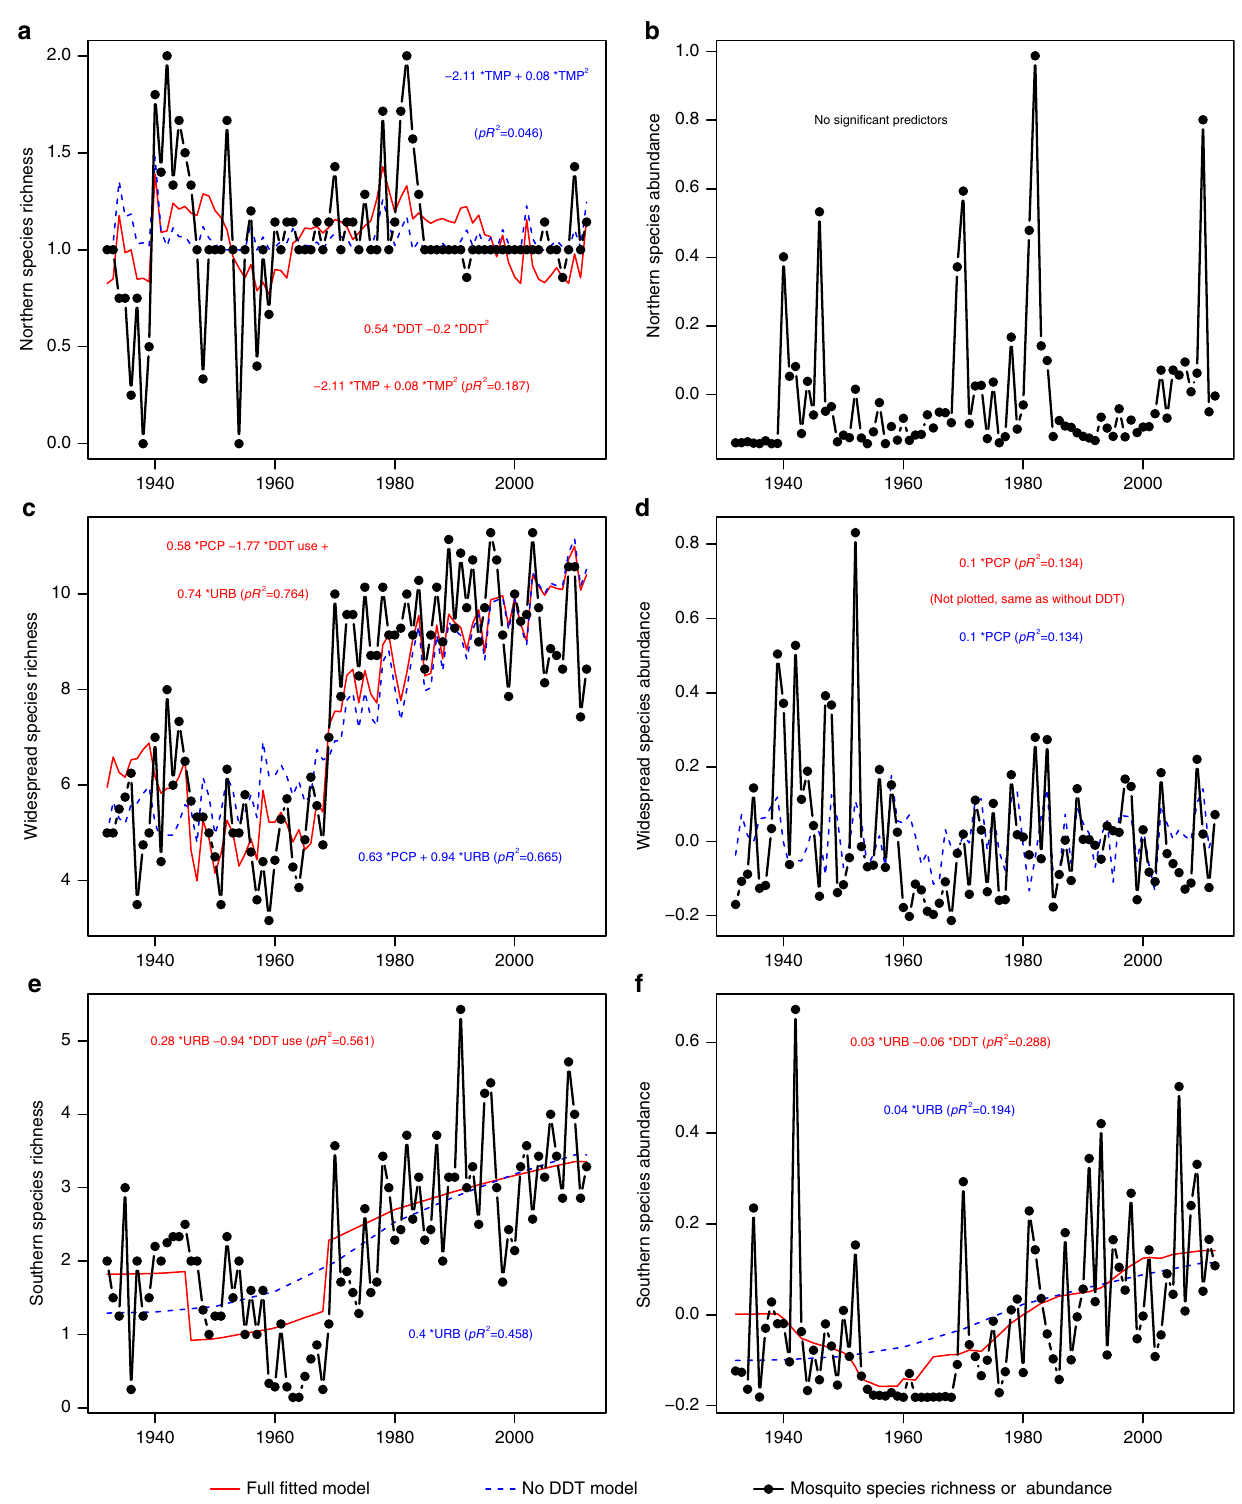
Figure 7 | Regional fitted models and data for mosquito species richness and abundance in New Jersey. Black line and dots show mosquito species richness for Northern ( a ), Widespread ( c ) and Southern ( e ) groups of mosquitoes or relative abundance ( b , d , f ). Red lines show full models, and blue dashed lines shows reduced models excluding DDTparameters. The equation in each panel gives the fitted model with all significant predictors ( P o 0.05) and fraction of variance explained (pseudo- R 2 , ‘ pR 2 ’) from the generalized least squares models (red font-full model, blue font- reduced model with DDT parameters excluded). The abbreviations designate DDTconcentration (DDT, Z -scores), DDTuse by the mosquito control districts (yes/no), precipitation (PCP, standardized precipitation index), urbanization (URB, human population in 100,000), average annual temperature November through October (TMP, (cid:2) C). For relative variable significance in the model see Table